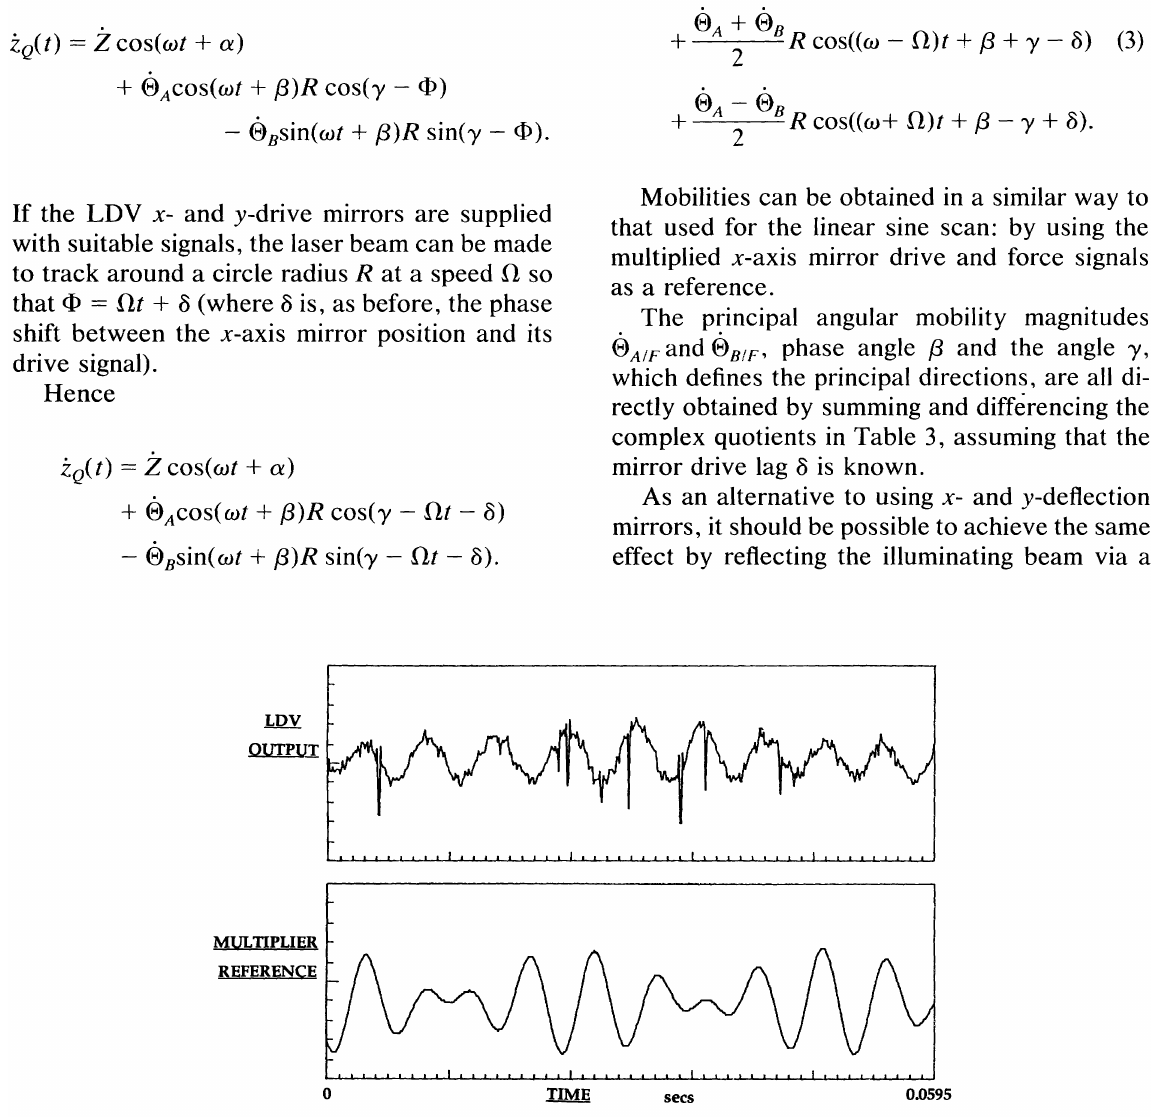
FIGURE 5 LDV and reference